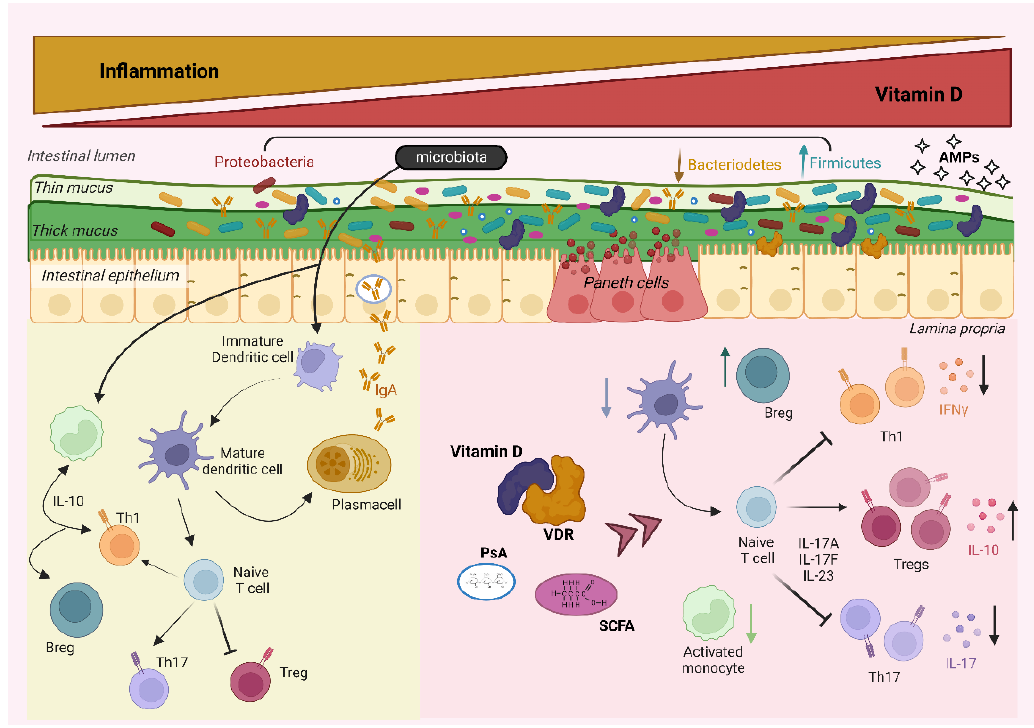
Figure 1. Gut microbiota and vitamin D modulation of the immune system. On the right side of the figure, an anti-inflammatory milieu, with a balanced microbiota composition, in the presence of normal vitamin D levels, which ensure intestinal barrier integrity, support a tolerogenic immune system setting. On the left side, a pathologic status with high levels of inflammation, low levels of vitamin D, and a decreased heterogeneity of microbiota, which promote immune cell activation while suppressing a regulatory phenotype. (AMPs, antimicrobial peptides; PsA, polysaccharide A; SCFA, short chain fatty acid; and VDR, vitamin D receptor). ↑ increased levels; ↓ decreased